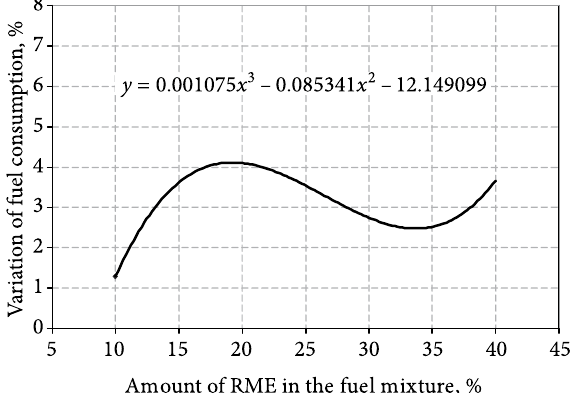
Fig. 3. The relationship between the variation of fuel consumption and the amount of RME, compared to pure diesel oil consumption The curve in Fig. 3 shows that when 20% of RME is added, fuel consumption grows by about 4%, compared to pure diesel oil consumption while the use of 30% of RME in the mixture with diesel oil increases fuel con- sumption by about 2.5%. A further increase in the per- centage of RME in the mixture leads to a further increase in fuel